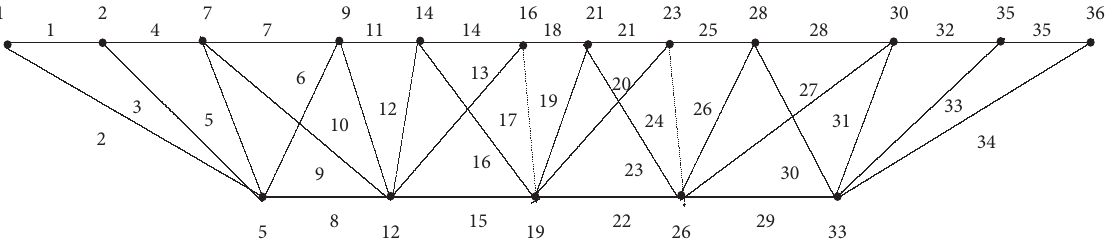
Figure 7: A classical mean labeling of L ( M ( P